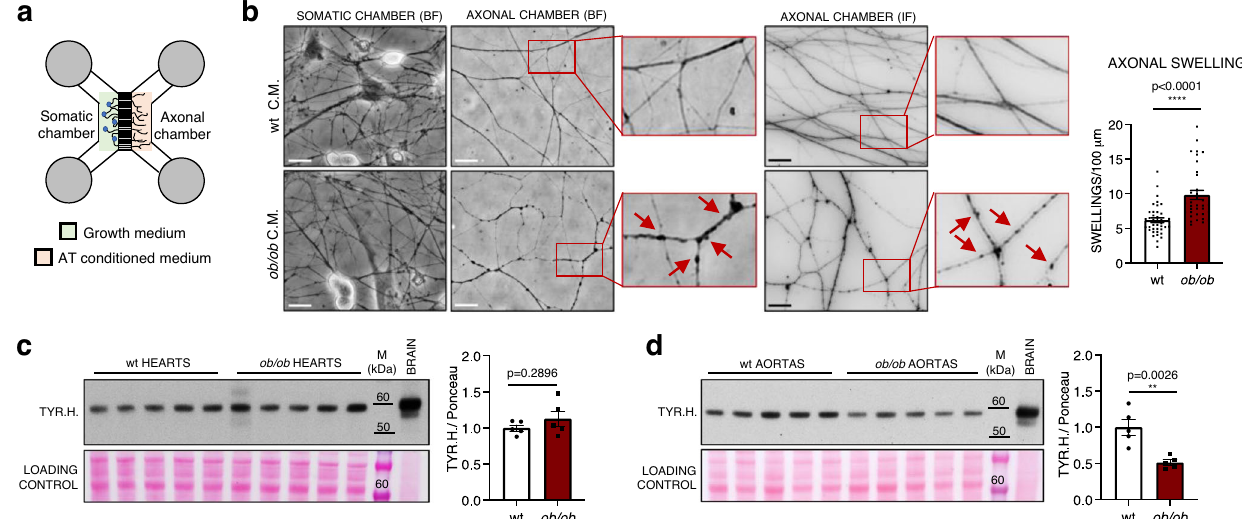
Fig.5|LocaleffectofAT-conditionedmediaonculturedsympatheticneurons. a Schematic cartoon showing the structure of micro fl uidic devices employed for sympathetic neuronal cultures. b Representative images of SCG sympathetic neu- rons seeded on micro fl uidic devices, with the axonal chamber incubated for 24h with either wt or ob/ob fat explants conditioned media (C.M.) showing bright fi eld appearance (BF, left panel) and β 3-tubulin staining (IF, right panel) of sympathetic neurites. Arrows point at axonal swellings. Scale bars: 20 µ m. Bar chart shows the quanti fi cation of axonal swellings normalised on total axonal length. Data are